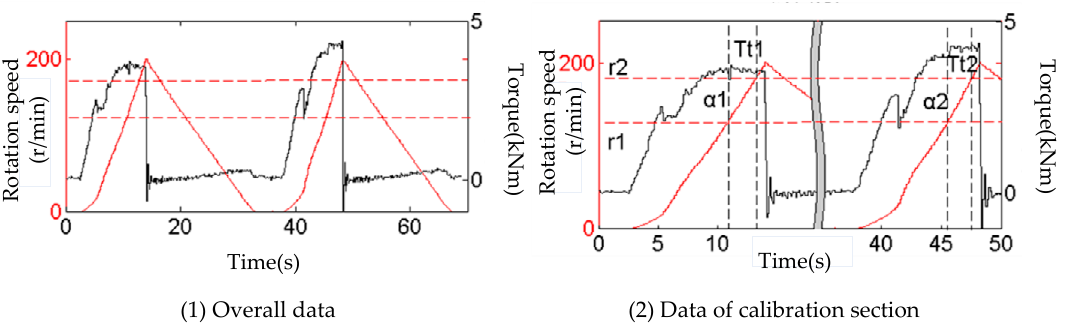
Figure 22. Test results under equivalent inertia of 2232.05 kg · m 2